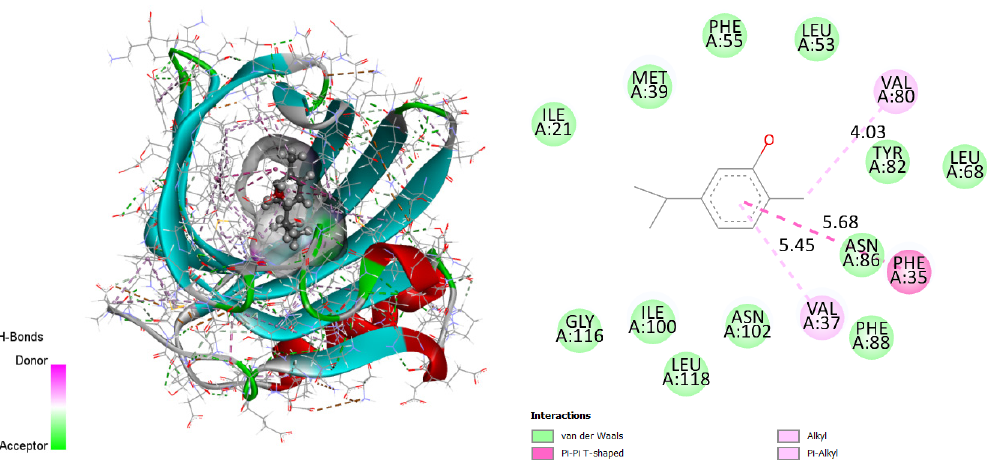
Figure 3. Two-dimensional and three-dimensional docking poses proving carvacrol interactions in the binding site (binding energy 7.04 kcal/mol). This figure was made with Discovery Studio 3.5.